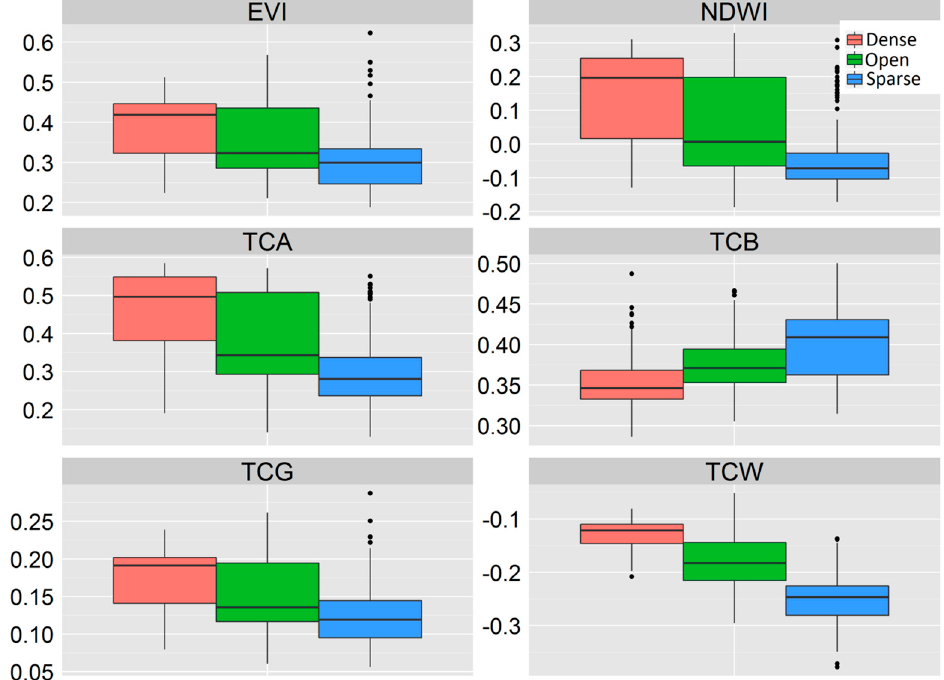
Figure 3. Boxplots of the selected vegetation indices for different classes of woody dominance in the Upper Guinean Forest region of West Africa. Table 2. Area under the receiver operating characteristic curve (AUC) for vegetation indices in relation to classes of woody vegetation cover. Dense vs. Open Dense vs. Sparse